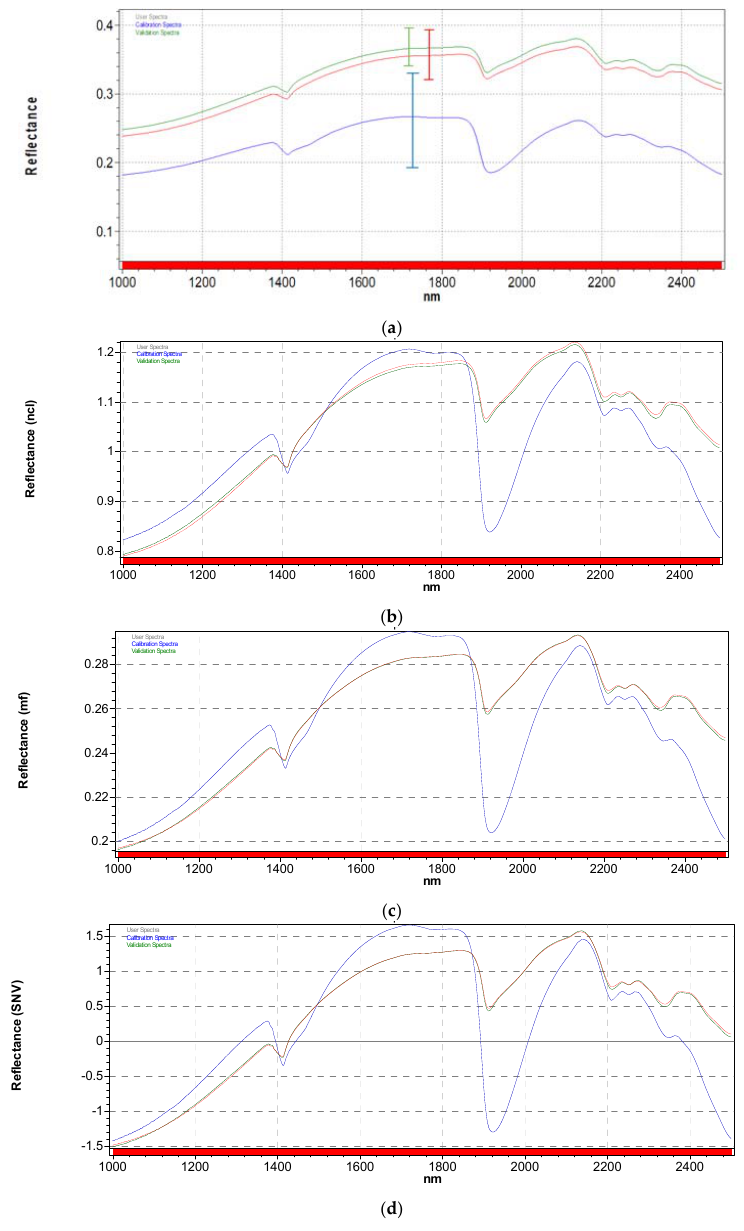
Figure 4. Pre-processing treatment on ( a ) average NIR spectra calculated separately from the WS (blue spectrum), DS (red spectrum) and GSS (green spectrum): effects of ( b ) normalization by closure (NCL); ( c ) multiplicative scatter correction (MSC); ( d ) standard normal variate